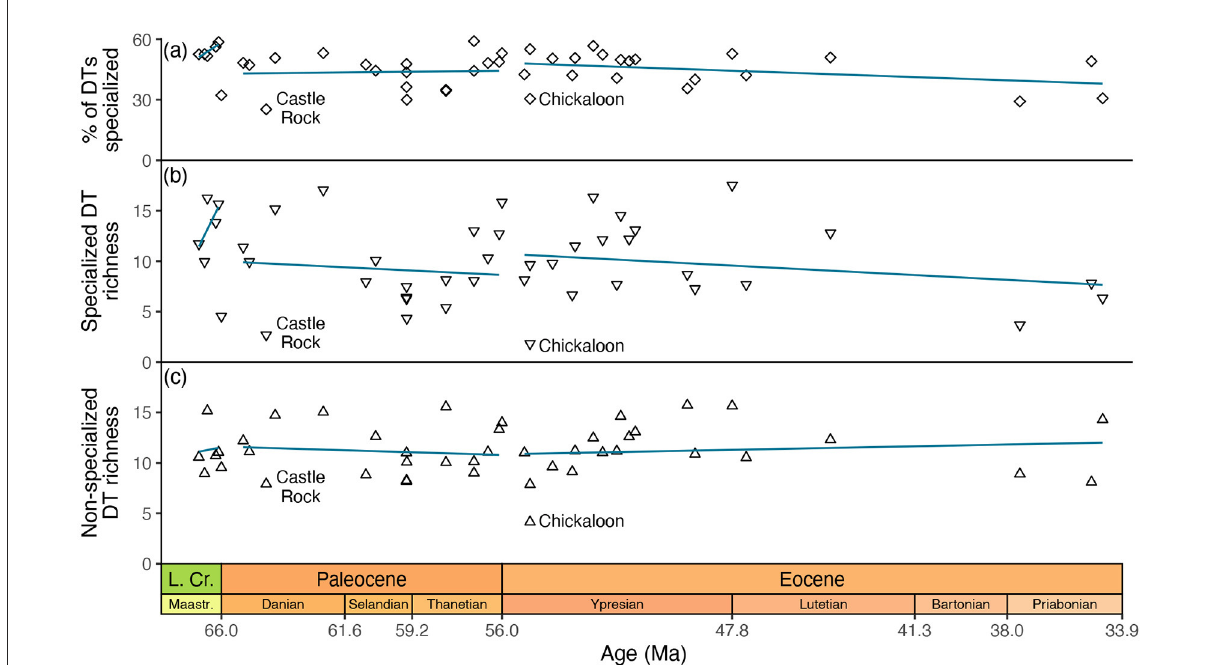
FIGURE4 Specialized and non-specialized herbivory at assemblages in Currano et al. (2021)’s compilation that span the Cretaceous through Eocene. The percentages in (a) are based on estimates that were calculated after richness was rarefied to 300 leaves; (b,c) show those estimates. Trendlines for each epoch are in